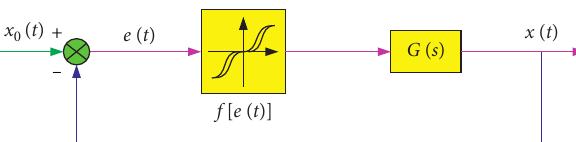
Figure 6: Transfer block diagram of nonlinear closed-loop feed- back